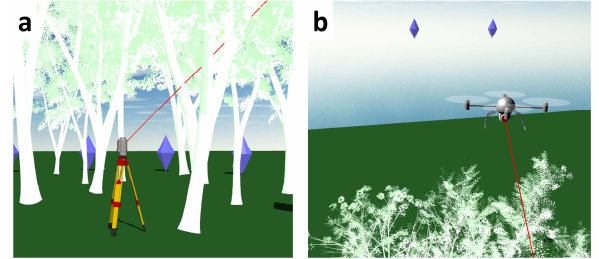
Figure 1: Exemplary visualization of HELIOS forest scan simulations. (a) Terrestrial laser scanning, (b) unmanned aerial vehicle-borne laser scanning. Red line: currently simulated laser beam. Blue diamonds: TLS scan positions or ULS way points